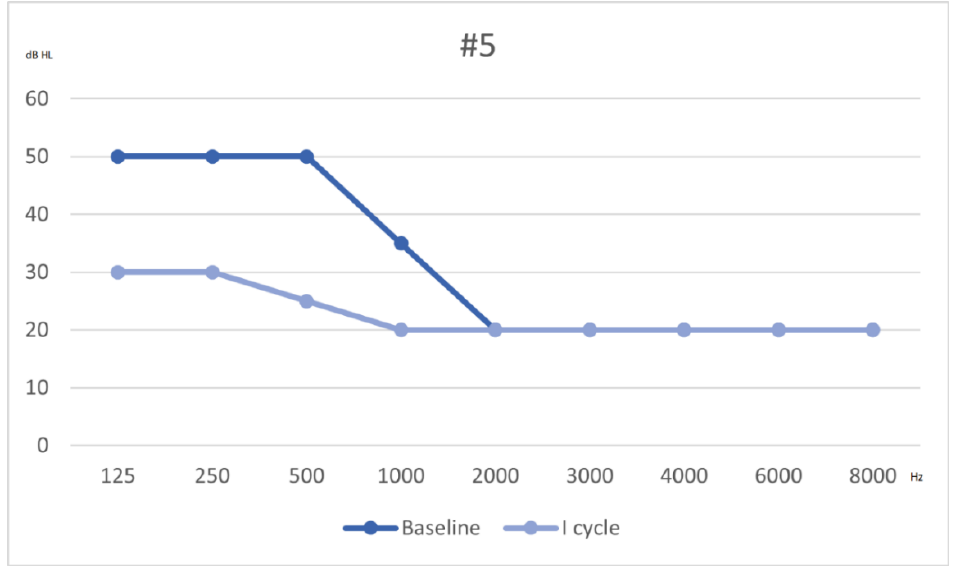
Figure 6. Hearing threshold from baseline to outcome (after 1 cycle of